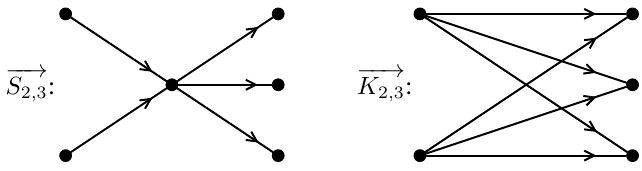
Figure 6: An oriented star and an oriented complete bipartite